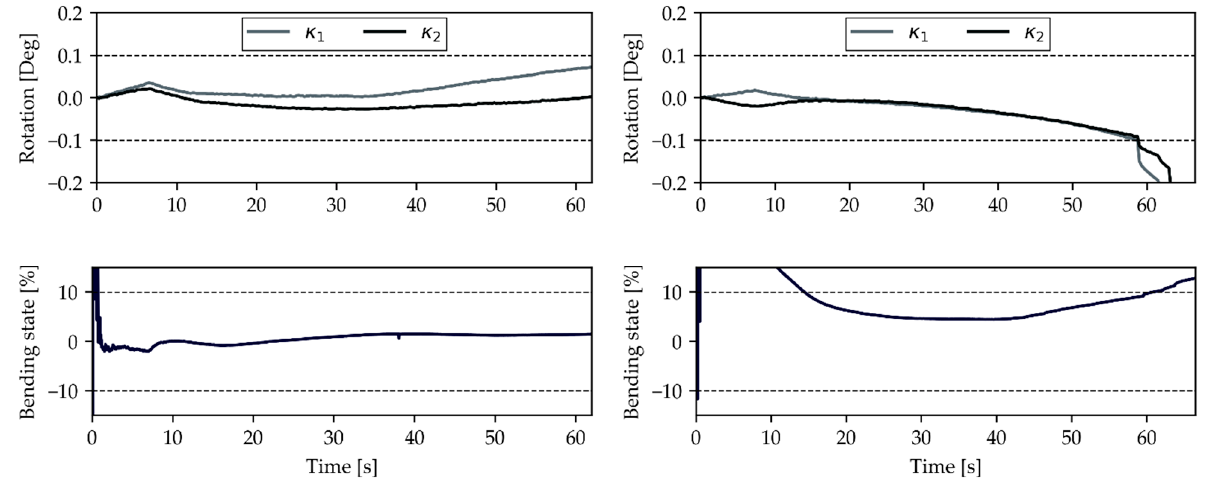
Figure 7. Comparison of the newly proposed bending criterion ( upper plot ) with the state-of-the-art ( lower plot ) on a UD [0] 6 laminate in 0° direction. Left side shows specimen 1, the right side presents data obtained from specimen 4 of the test series.